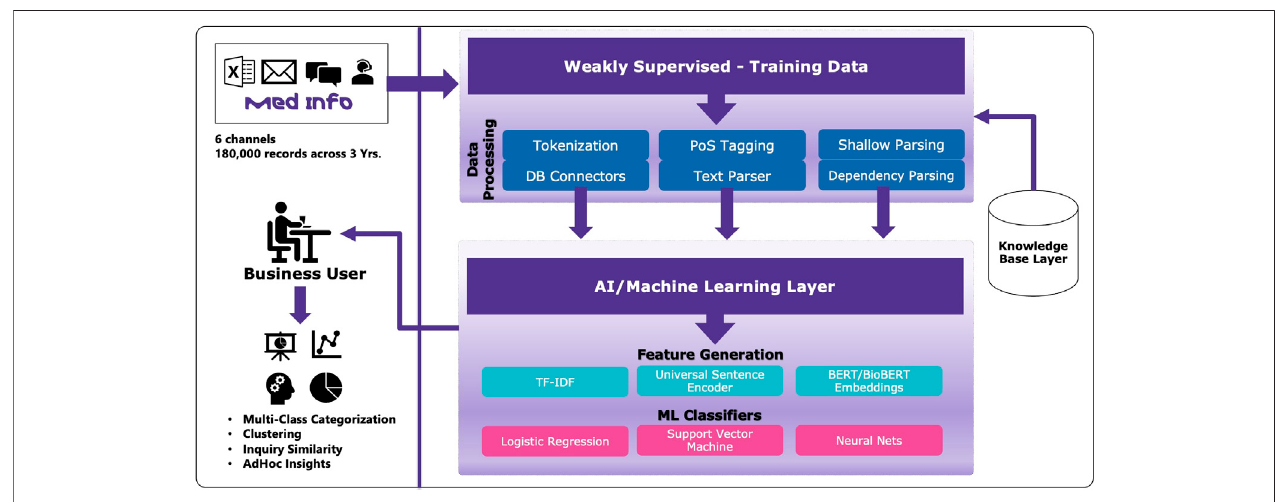
FIGURE 1 | Overview of solution